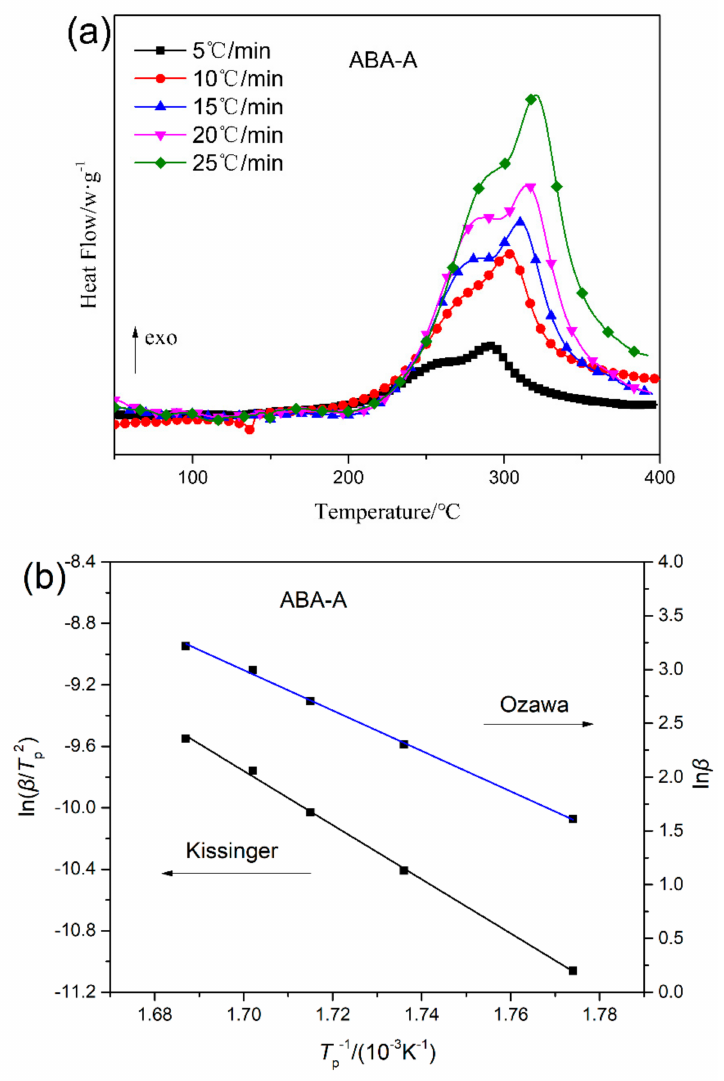
Figure 7. ( a ) DSC curves of the ABA-A copolymer at different heating rates; ( b ) the relationship of ln( β / T p 2 ) versus 1/ T p and ln( β ) versus 1/ T p